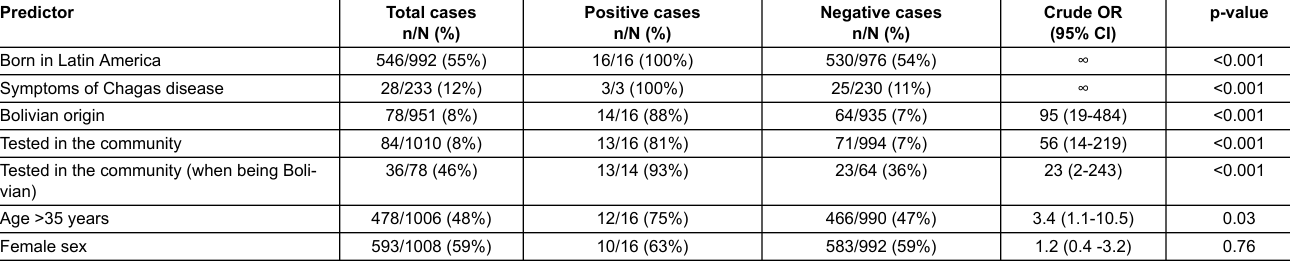
Table 3: Predictors of being positive for Chagas disease.